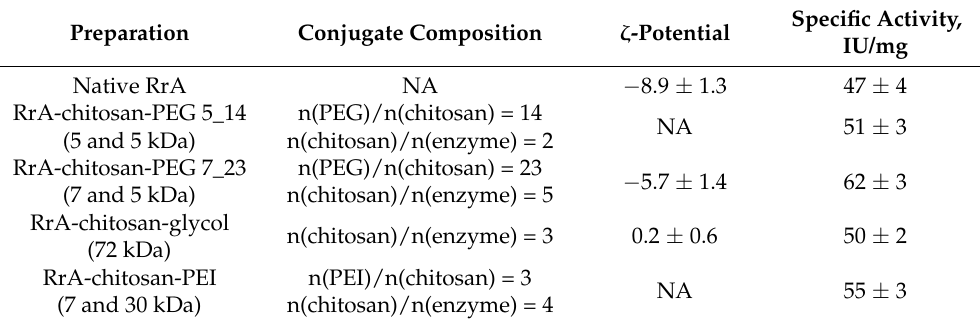
Figure 5. CD spectra of native RrA and its conjugates RrA-chitosan-PEG, RrA-chitosan-glycol and RrA-chitosan-PEI. C(RrA) = 1 mg/mL, 0 mM sodium phosphate buffer, 37 °C, pH 7.5. Table 5. The composition and activity of RrA conjugates. The hydrolysis activity for 20 mM L-asparagine was measured in 10 mM PBS, pH